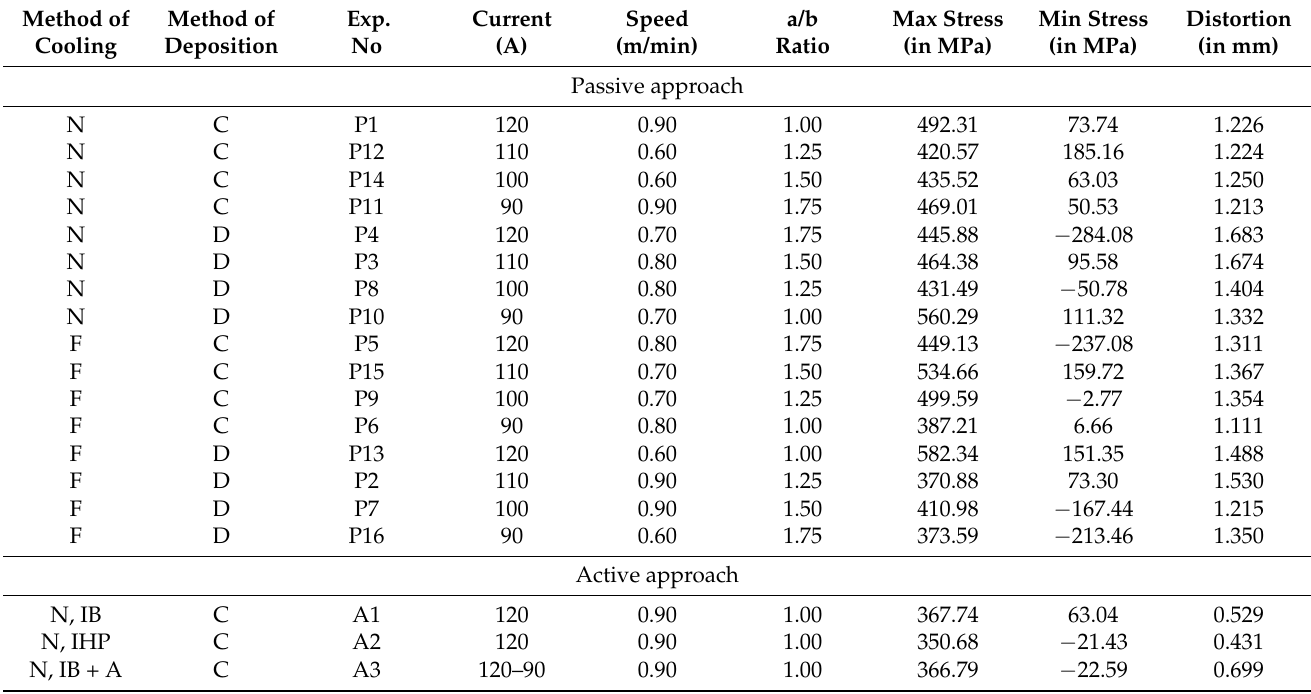
Table 5. Experimental results after the